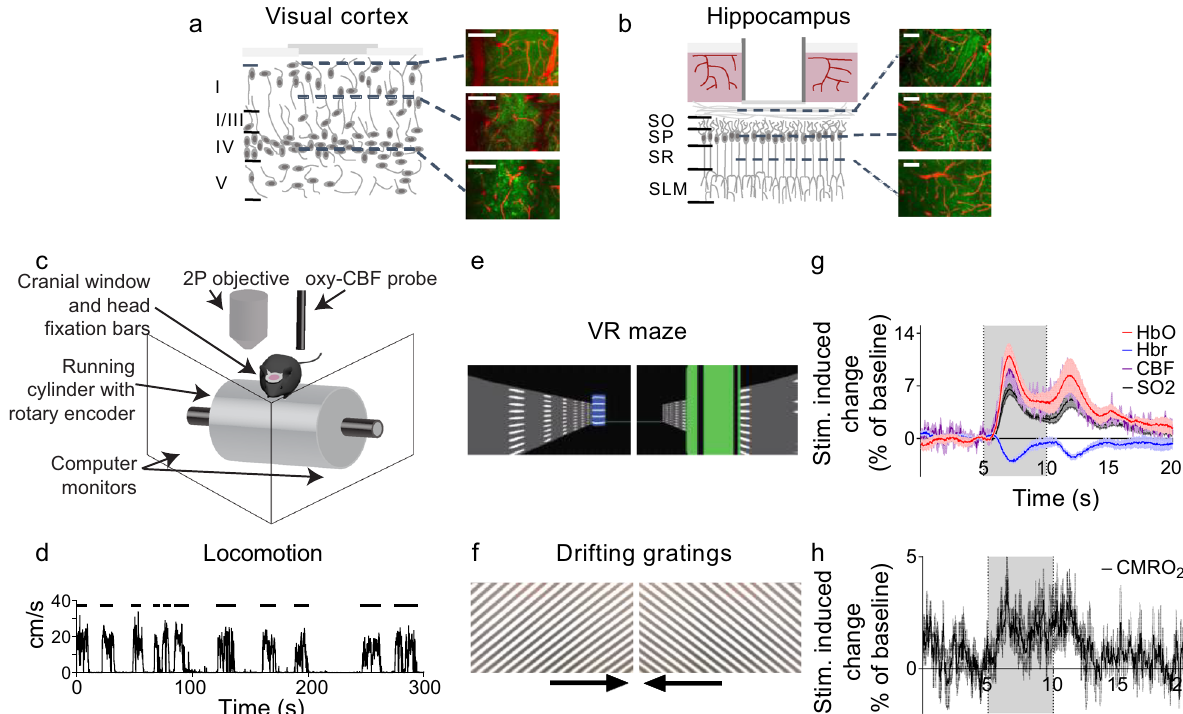
Fig. 1 Experimental set-up and example haemodynamic data. Representative schematic showing the GCaMP6f-positive pyramidal neurons (green) and blood vessels (red) accessible for two-photon imaging after a visual cortical or b hippocampal surgery, with example maximum-projected images across each layer. Scale bars represent 100 µ m, and similar z-stack images across layers were taken for nine animals in HC and 11 animals in V1. c Schematic of the imaging set-up. Either the two-photon objective or oxy-CBF probe was used to collect data while the mouse was head- fi xed but awake and able to run on the cylinder. d Representative locomotion recorded by the rotary encoder during one imaging session (centimetres per second). Distinct periods of running are indicated by the black bars. A virtual reality maze e or drifting gratings f were presented on the screens in c . Locomotion advanced the mice through the virtual reality maze. The arrows beneath the drifting gratings display show the direction the gratings travelled. g Example, haemodynamic recordings from visual cortex using the oxy-CBF probe during visual stimulation (grey bar represents stimulation, N = 4 animals, 10 sessions, 202 trials). h The cerebral metabolic rate of oxygen consumption (CMRO 2 ) is calculated from the haemodynamic parameters collected using the oxy-CBF probe for the data in g (see Methods). All data traces are unsmoothed averages, and error bands represent mean ±